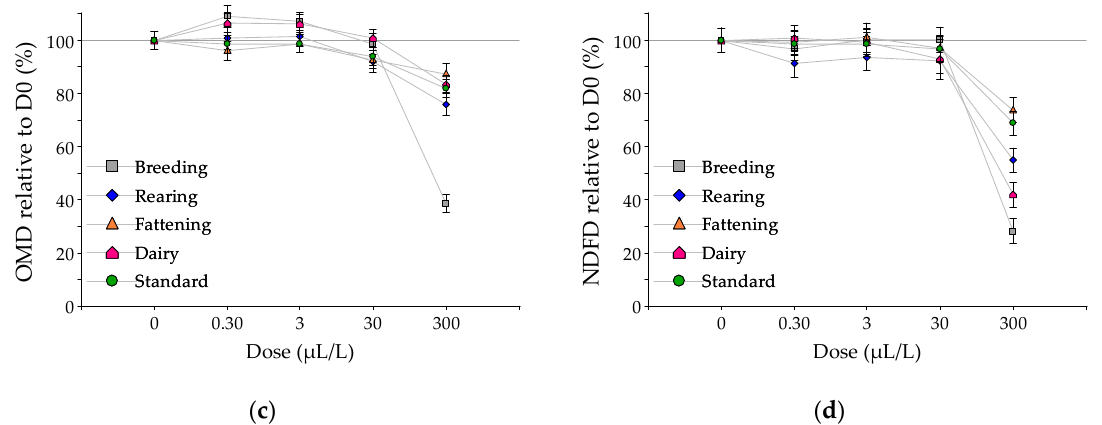
Figure4. Relativeresponsescomparedtocontrol(dose0 = 100%)for( a )totalgasproduction; ( b )methane